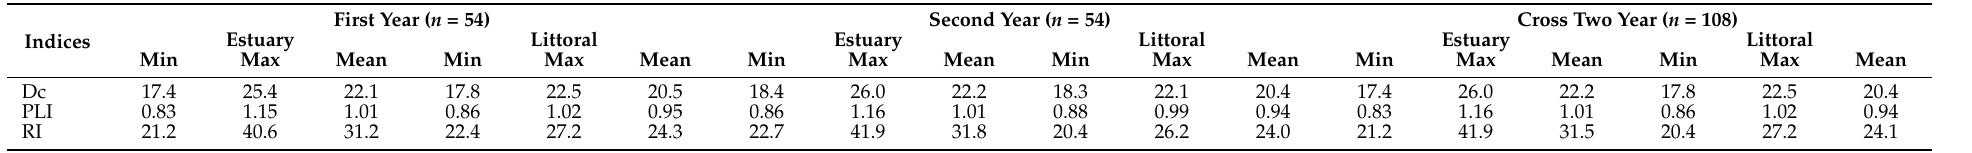
Table 7. The statistical description of the degree of contamination (Dc), pollution load index (PLI), and potential ecological risk index (RI) in studied sediment